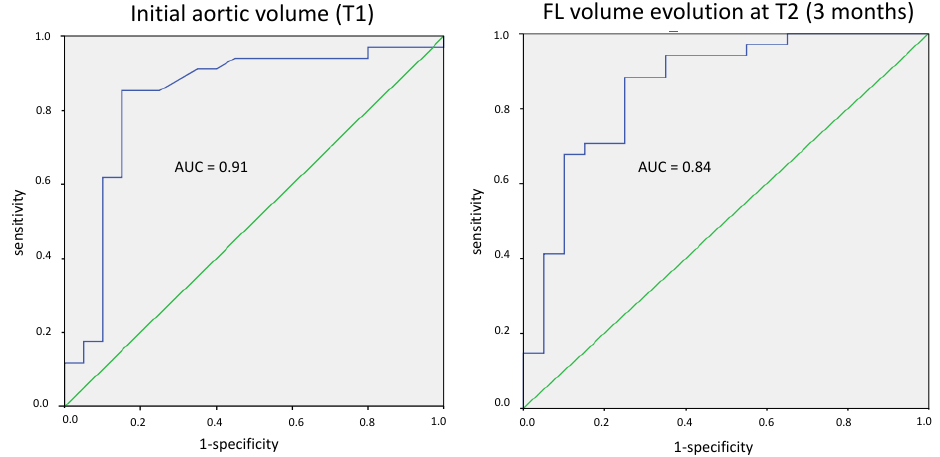
Figure 4. ROC curves showing: sensitivity and specificity of the initial false lumen (FL) volume at T1. Sensitivity and specificity of the FL volume evolution at 3 months.